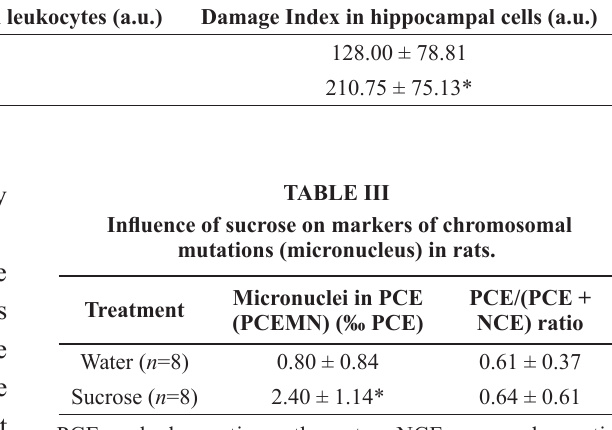
PCE: polychromatic erythrocytes. NCE: normochromatic erythrocytes. *significant at the p <0.05